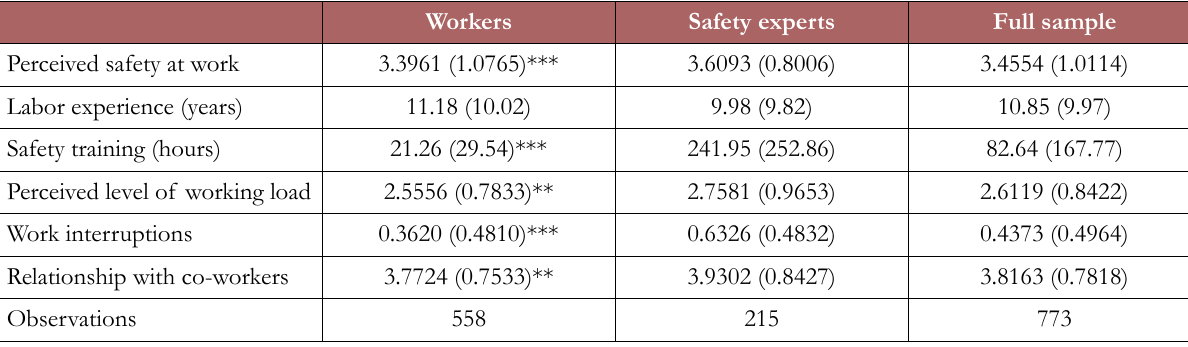
Table 2. Descriptive statistics for the selected